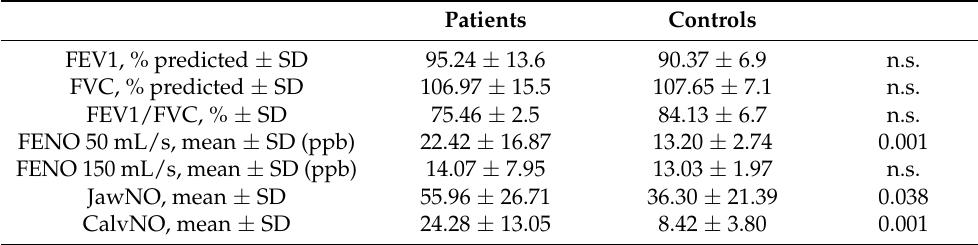
Table 3. Comparison of lung function tests and F E NO levels in patients and controls.